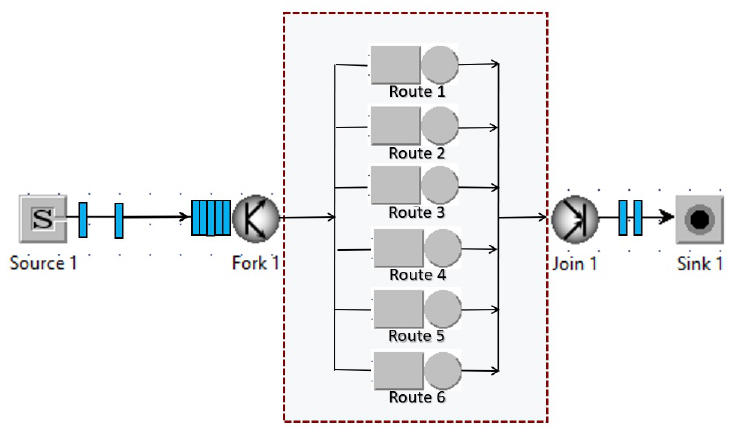
Figure 7. Layout of the model for the computation of the best